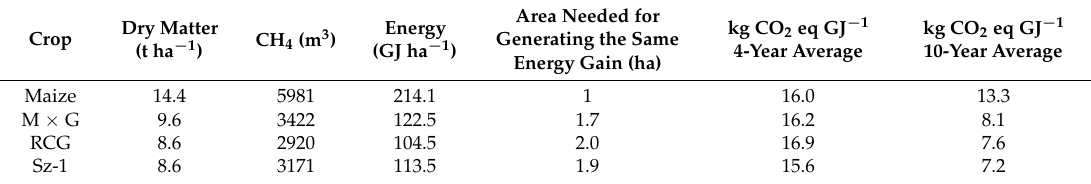
Table 9. Summary of final figures: average harvest used for